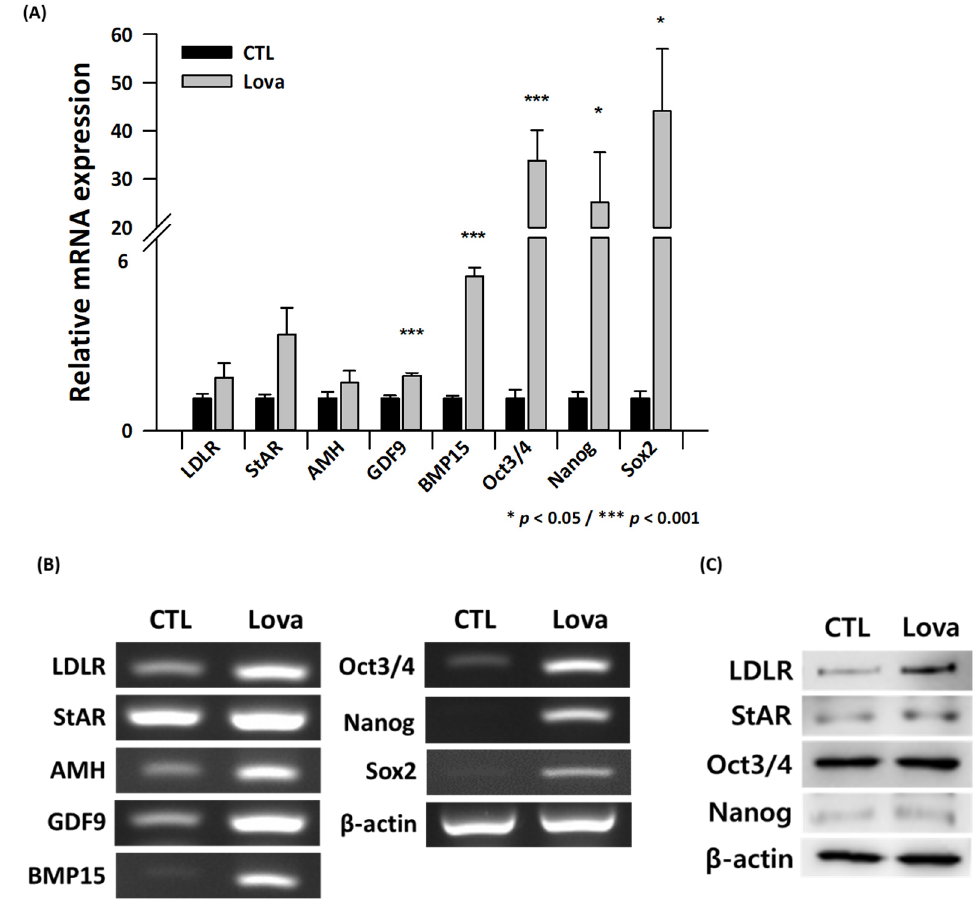
Figure 3. Expression of steroidogenesis and ovarian function markers in lovastatin-treated ovaries. ( A ) Quantitative real-time PCR analysis of LDLR, StAR, AMH, GDF9, BMP15, Oct3/4, Nanog, and Sox2 expression normalized against β -actin expression in control (CTL) and lovastatin-treated (Lova) ovaries. Data are the mean ± standard error of the mean of three replicates (* p < 0.05 and *** p < 0.001 versus the control group) ( n = 3). ( B ) RT-PCR analysis of control (CTL) and lovastatin-treated (Lova) ovaries. ( C ) Western blot analysis of control (CTL) and lovastatin-treated (Lova)